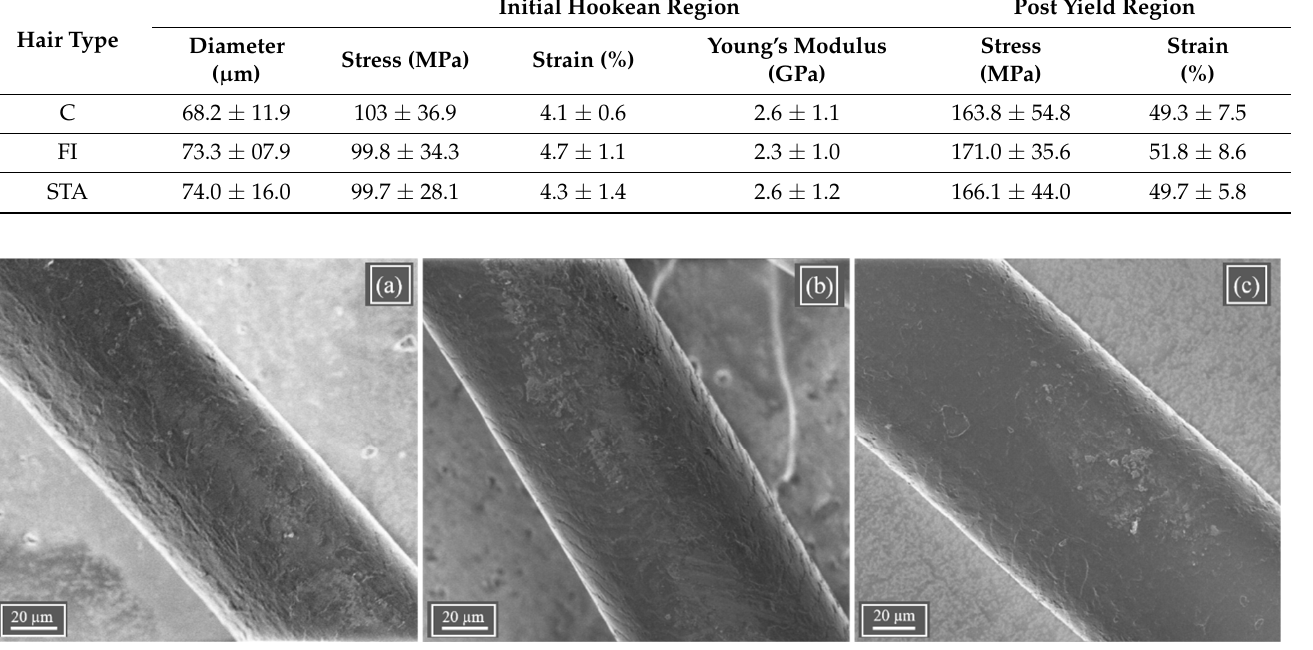
Figure 6. SEM images of ( a ) C, ( b ) FI, and ( c ) STA hair.